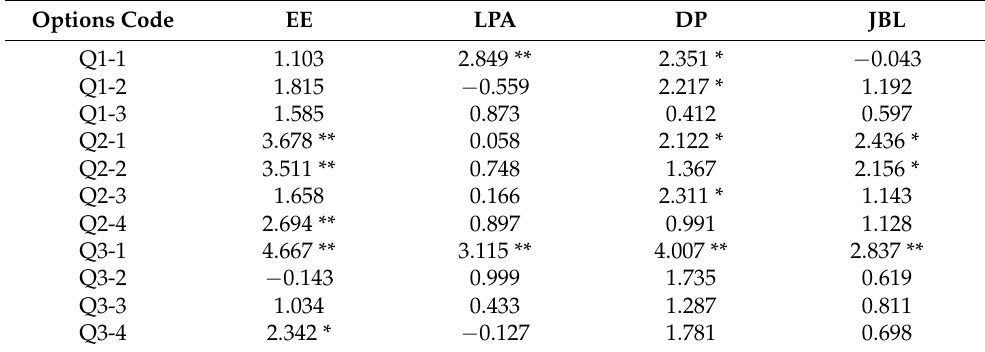
Table 6. Test and analysis results of negative perception and job burnout (N =